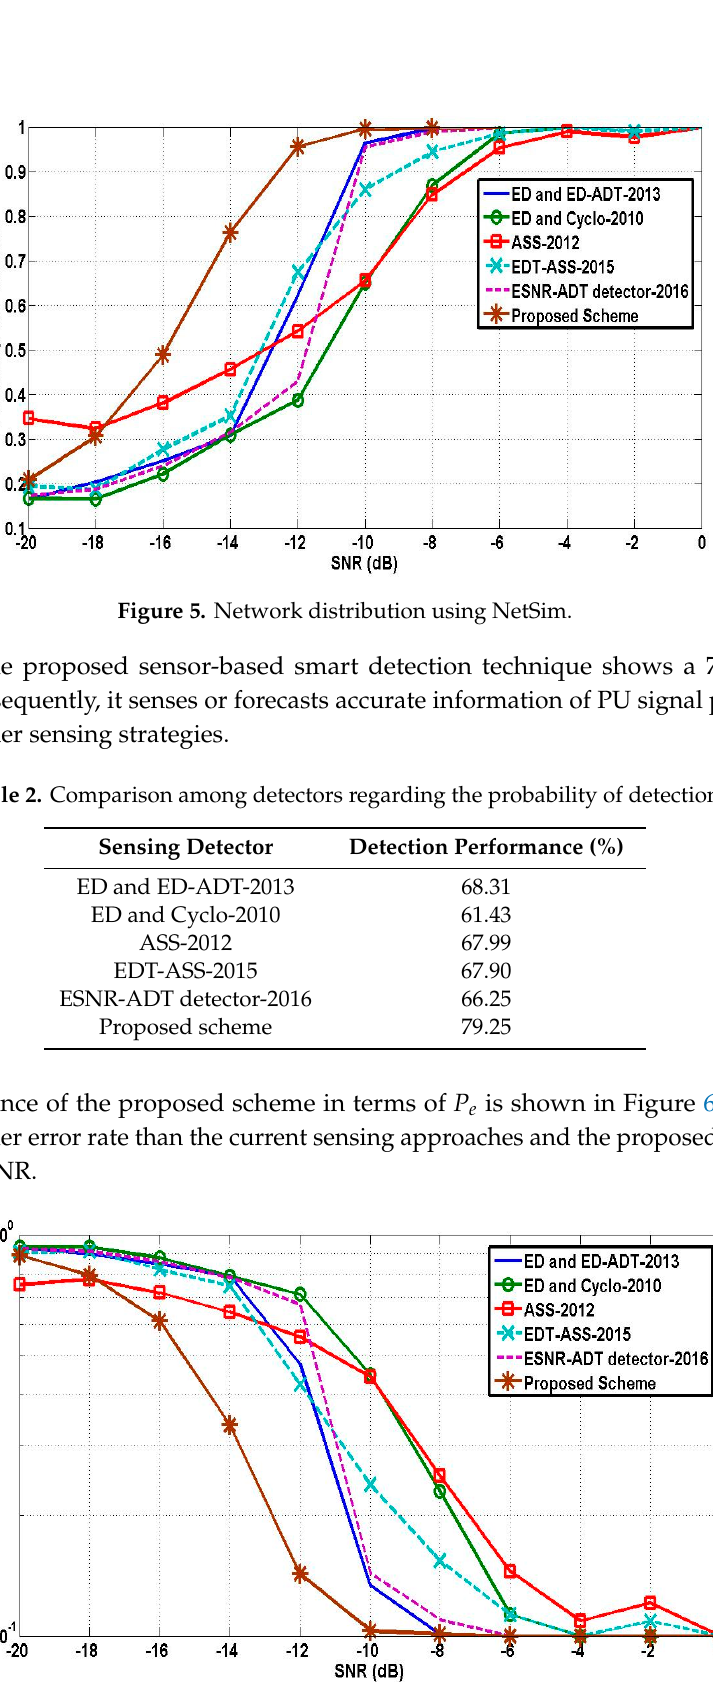
Figure 6. Error rate versus signal-to-noise ratio (SNR) values.